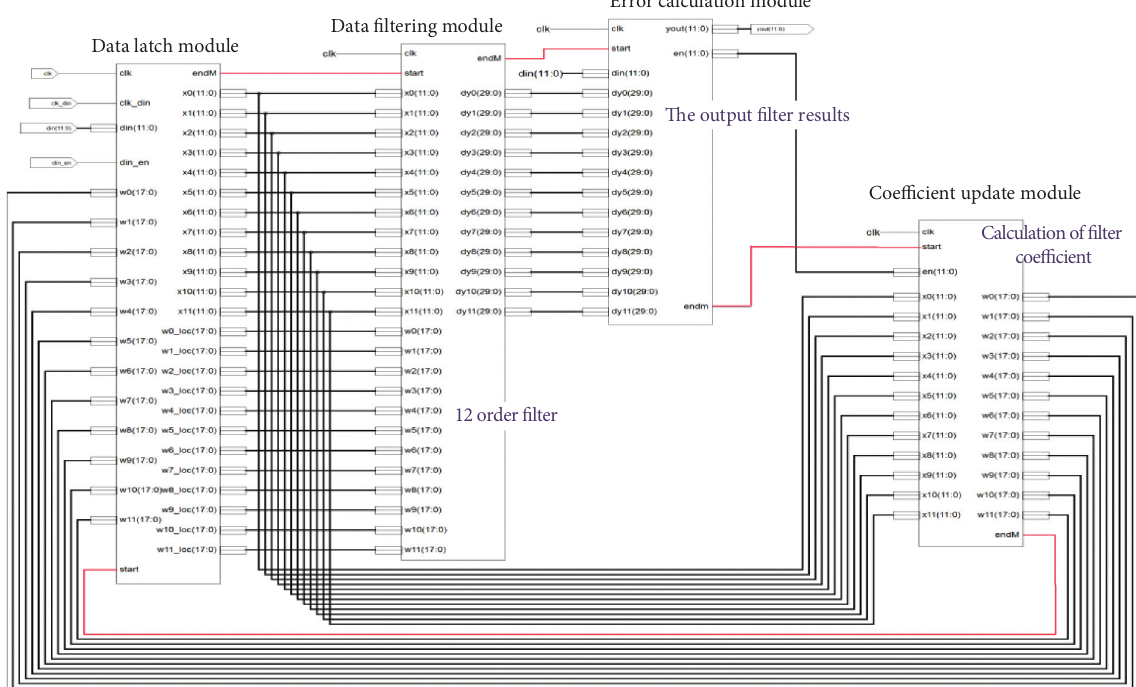
Figure 10: Schematic diagram of the LMS filter top